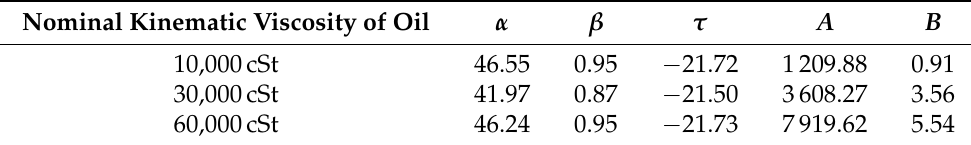
Figure 6. Graphs of the residual standard deviation and the Pearson correlation coefficient for oils of nominal kinematic viscosities: ( a , b ) 10,000cSt, ( c , d ) 30,000cSt, ( e , f ) 60,000cSt. The procedure given in Algorithm 1 allows for determining such τ k ∈ Ω , for which the Weibull approximation fits the empirical data best. The values α k , β k , A k and B k are connected with the τ k value determined this way. Table 2 presents the values of the Weibull distribution parameters for which the best approximation of the empirical data have been achieved. Table 2. Optimal coefficients of the Weibull distribution.